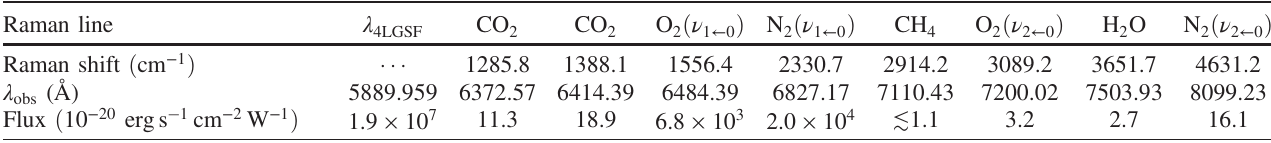
TABLE I. Integrated fluxes for the different laser-induced Raman lines from the uplink beam at an altitude of 27.6 km above sea level, normalized to the power of a (continuous-wave) 1-W laser shining at 5889.959 Å. Uncertainties on the quoted fluxes are ≲ 15% . For the fundamental Raman lines of N 2 and O 2 , the fluxes refer to the central peak only (i.e., the Q branch). The flux associated with the main Rayleigh line of the laser in the same observational setup is also